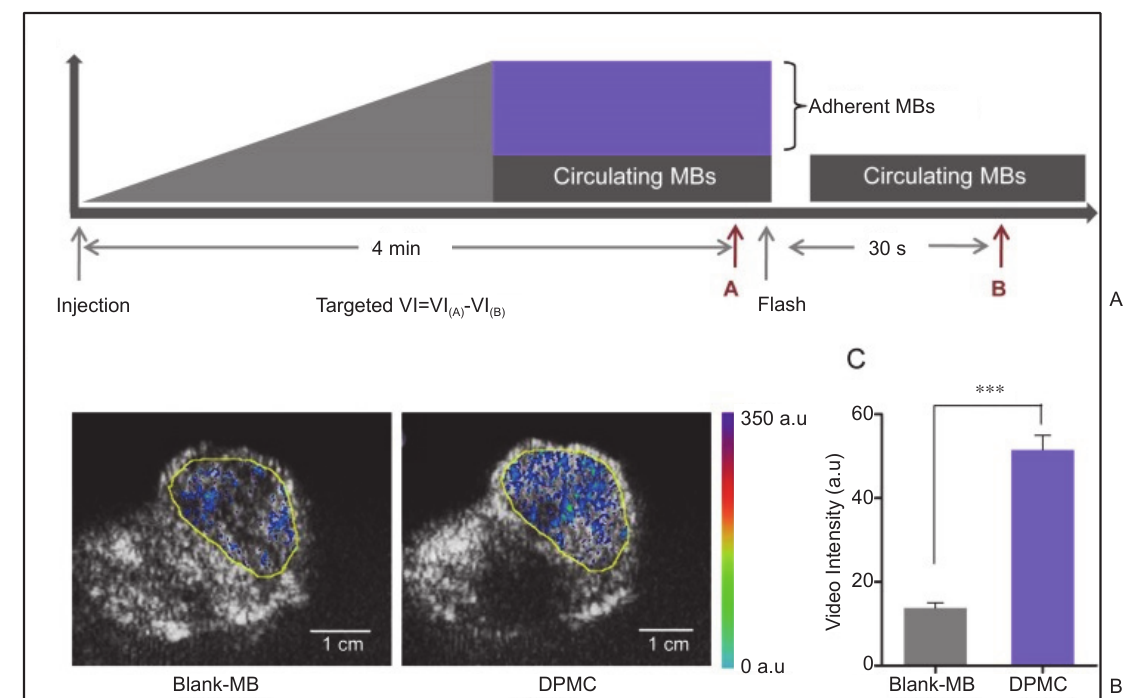
Figure 14 Schematic illustration of the image and analysis protocol (A). After monitoring for 4 min, targeted MBs were considered to adhere to the tumor site firmly. Blank MBs or DPMC were destroyed by the Flash mode of the ultrasound system. The process was monitored, starting from injection to at least 30 s after Flash destruction. The video intensity (VI) from adherent MBs (Targeted VI) was assessed by calculating the average pre- and post-destruction VI, and subtracting average post- from pre-destruction intensity. Ultrasound molecular images representing intensity from adherent blank MBs or DPMC displayed as color maps overlaid on B-mode images (B). Yellow line represents the region of interest (ROI). Image signals are quantitatively presented ( *** P <0.001) (C). (Reprinted with permission from reference [71])